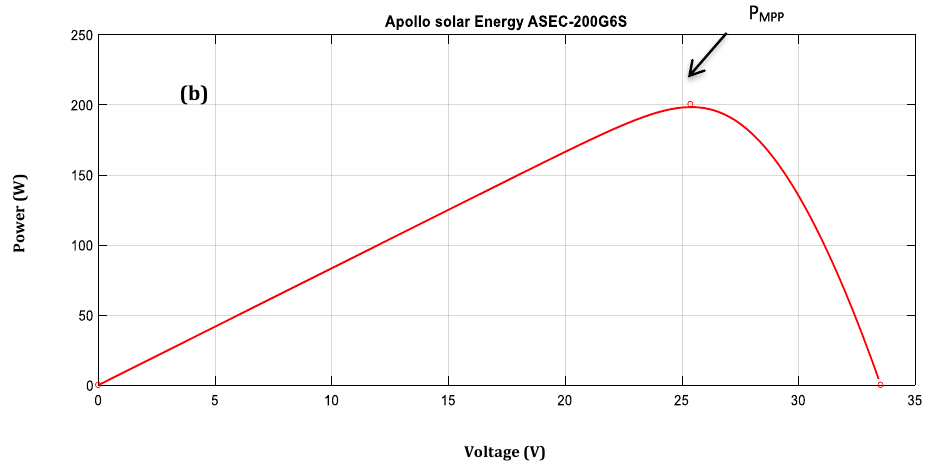
Figure 6. Characteristic curves of the PV module: ( a ) Current-voltage I-V curve, ( b ) Power-voltage curve P-V.